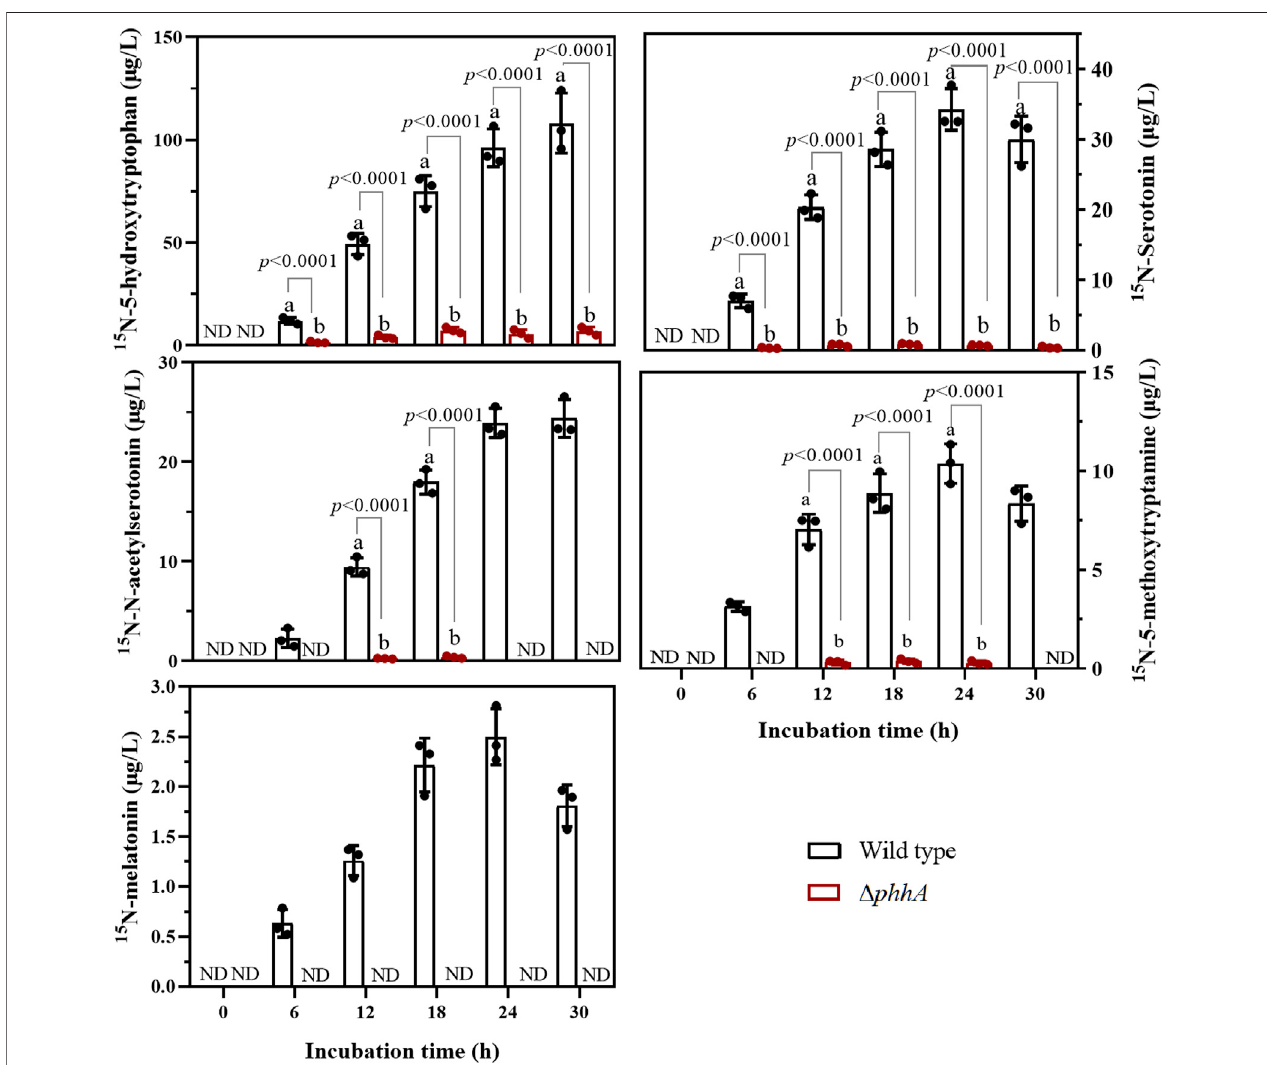
FIGURE 4 | Evolution of fi ve 15 N-metabolites in the melatonin biosynthesis pathway in wild-type and Δ phhA mutant P. fl uorescens cultures. Concentrations are expressed as μ g L − 1 .Each datapointrepresentsthemean ± standarddeviation( n (cid:2) 3). Differentlettersindicatesigni fi cantdifference withthetwo-tailedStudent ’ s t -test compared to the Δ phhA mutant in each time point. ND indicates this substance was not